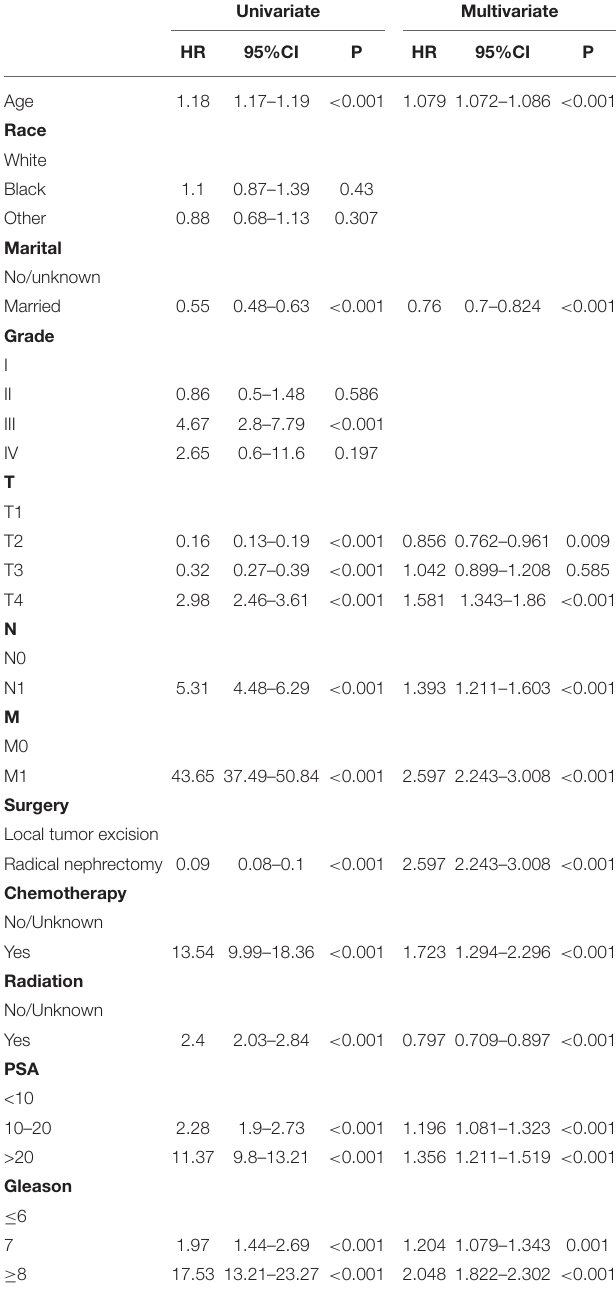
TABLE 2 | Univariate and multivariate analyses of CSS in training